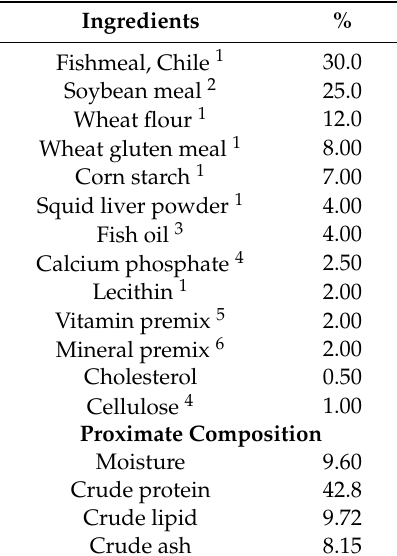
Table 1. Formulation and composition (% dry matter) of the basal diet for whiteleg shrimp. Ingredients % Fishmeal, Chile 1 30.0